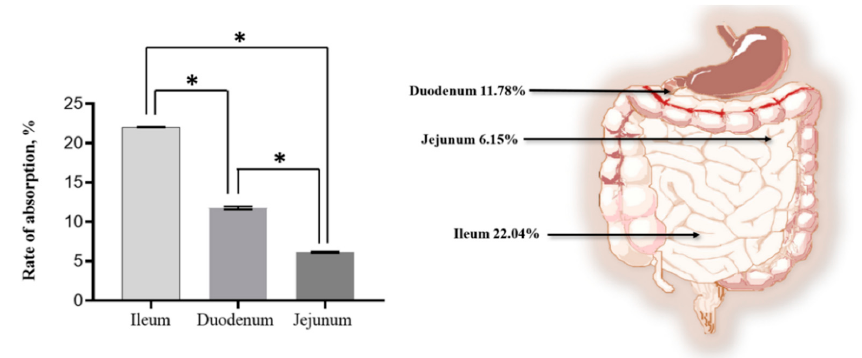
Figure 5. SMA-insulin micelle transportation across an intestinal rat ex vivo model. Transport of SMA-insulin through the rat duodenum, jejunum and ileum sections following a 4 h incubation. Quantification of insulin was performed using an ELISA kit and following the manufacturer instructions. Absorbance was measured at 450 nm. Data are expressed as mean ± SEM ( n = 6). The percentage of total SMA-insulin was analyzed using a one-way analysis of variance (ANOVA), * p < 0.05 denotes statistical significance.